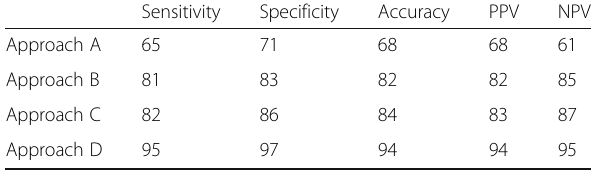
Table 1 Summarized the diagnosis of complete ACL tear by each diagnostic approach. Approach A indicates standard Table 2 Summarized the diagnosis of partial ACL tear by each sagittal images only; approach B, orthogonal sagittal and approach. Approach A indicates orthogonal sagittal images additional oblique sagittal images; approach C, orthogonal only; approach B, orthogonal sagittal and additional oblique sagittal and oblique coronal images; and approach D, sagittal images; approach C, orthogonal sagittal and oblique orthogonal sagittal, oblique sagittal, and oblique coronal images coronal images; and approach D, orthogonal sagittal, oblique ( p < 0.05) sagittal, and oblique coronal images ( p < Sensitivity Specificity Accuracy PPV